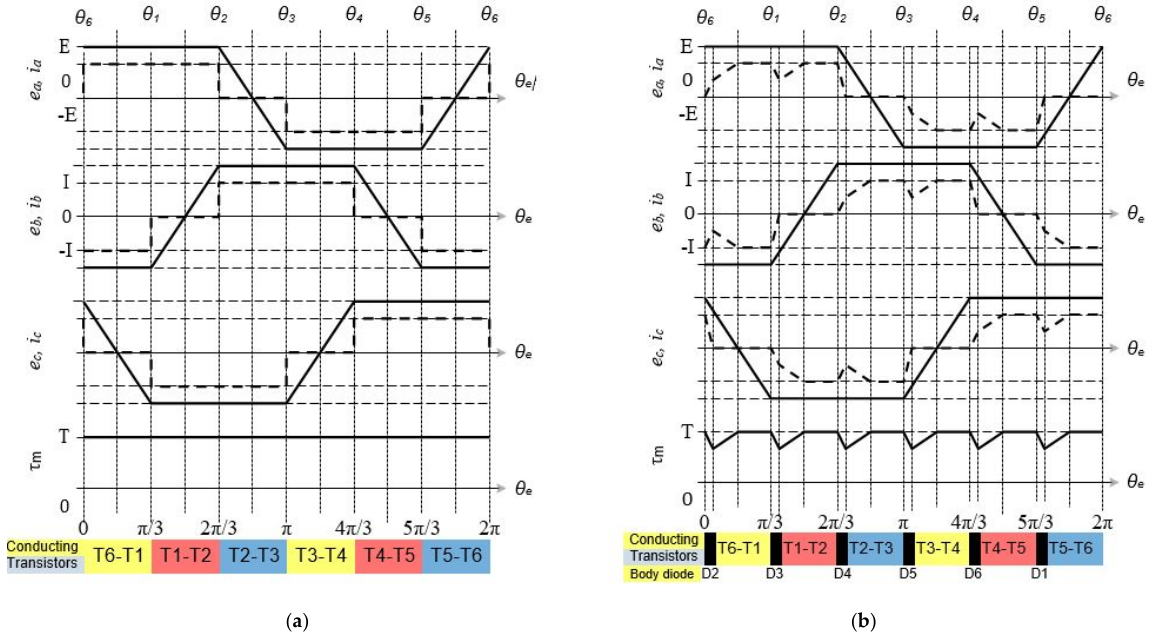
Figure 5. Back-emf ( e ), phase current ( i ), and torque ( τ m ) variation of PMBLDC motor for ( a ) ideal operation and ( b ) non- ideal (motor as inductive load) operation.